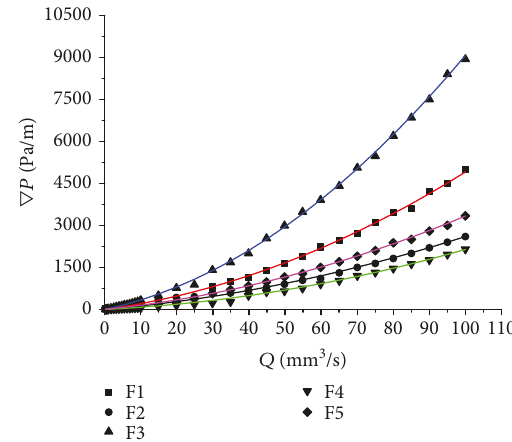
Figure 4: Relationship between pressure gradient and fl owrate in the 0 ° direction.